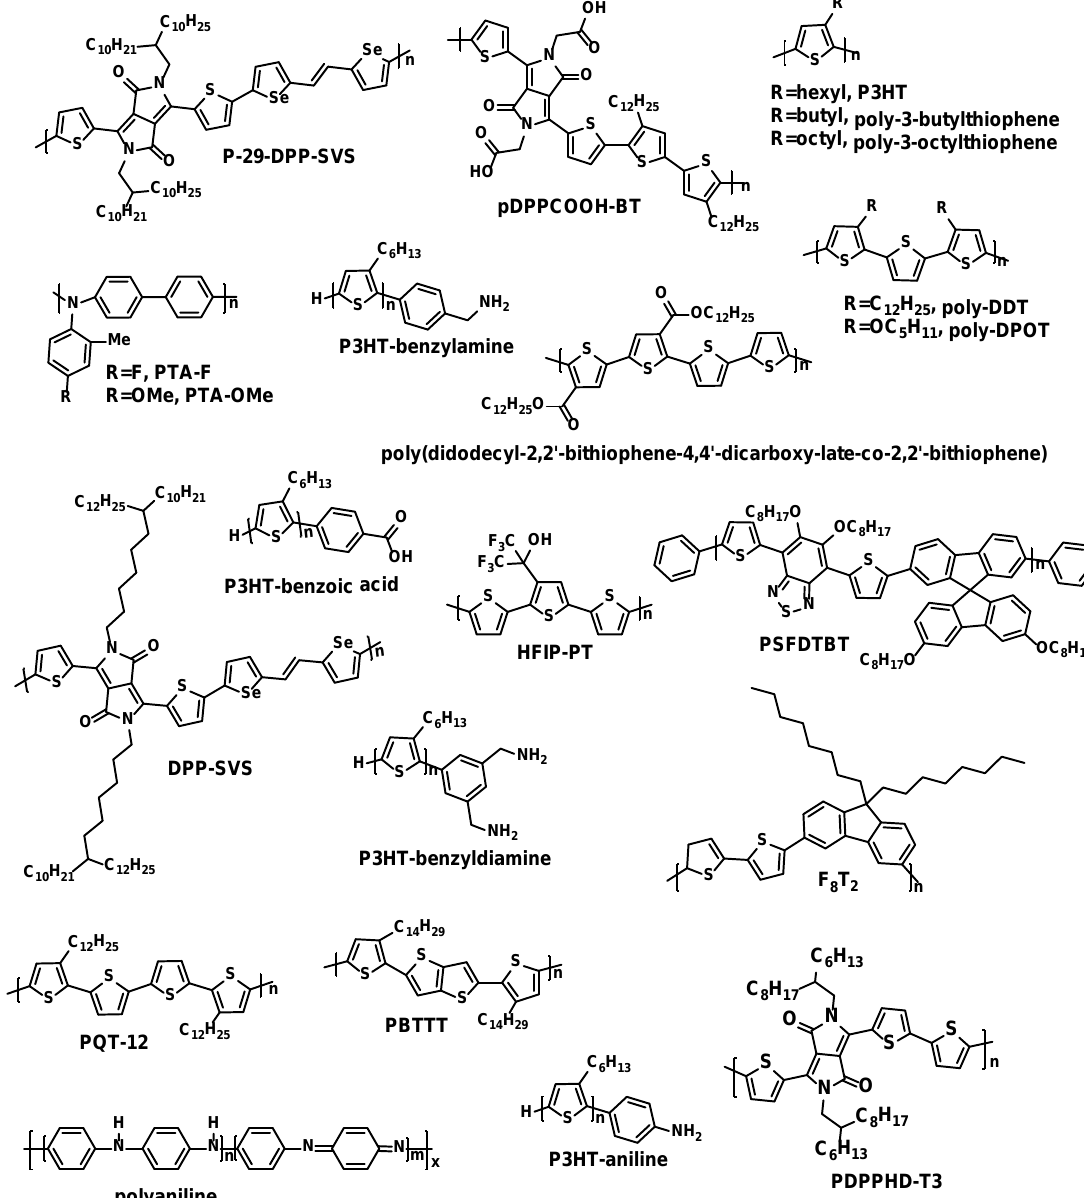
Scheme 1. Reported molecular structures of semiconducting polymer used in the OFET sensors.